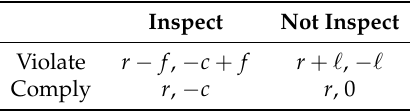
Table 1. Two-player perfect inspection game.